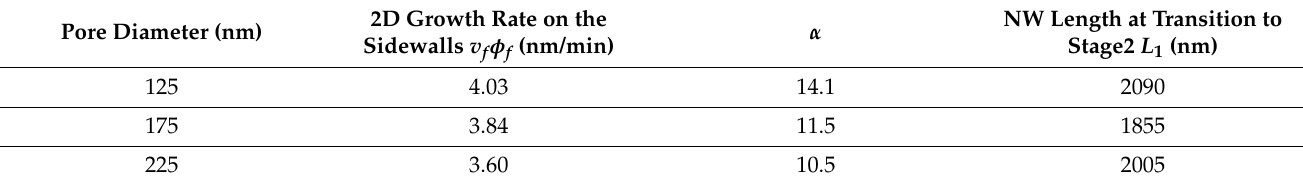
Figure 6. Evolution of the morphology of SAG GaAs NWs grown by MOVPE at 750 °C with different nominal pore diameters shown in the legends: ( a ) length, ( b ) radius, ( c ) volume, and ( d ) length–radius dependencies at different times. Symbols represent the data from Ref. [30]. Lines are the fits obtained within the model with the parameters summarized in Table 1. Table 1. Fitting parameters for SAG GaAs NWs grown by MOVPE.